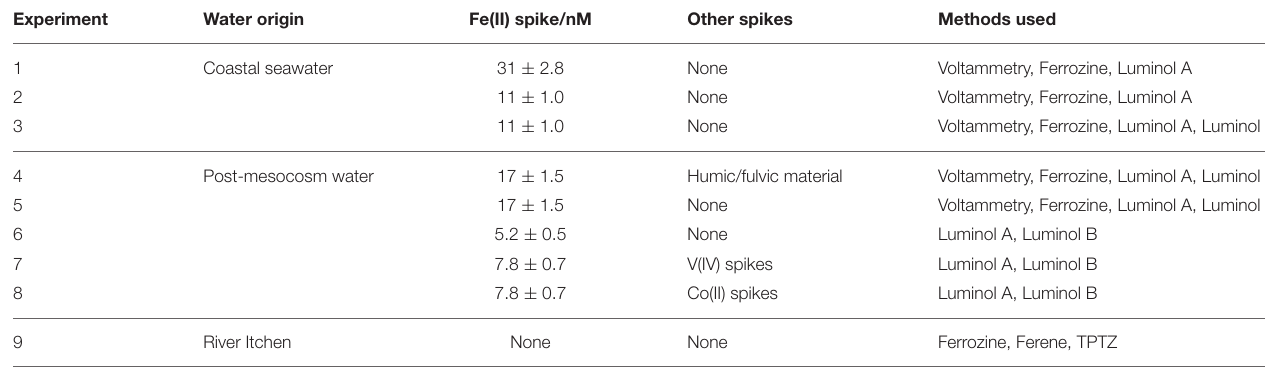
TABLE 1 | Set up of nine method comparison experiments where Fe(II) concentrations were measured simultaneously using multiple methods.